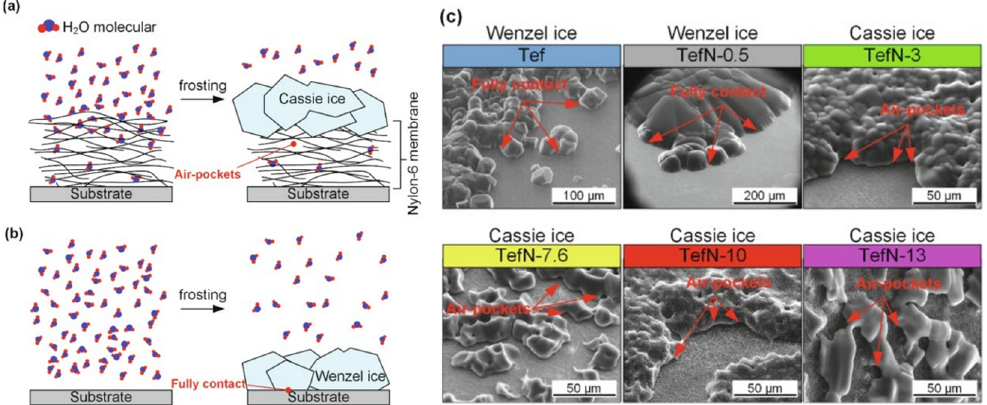
Figure 9. Ice morphology on studied surfaces. ( a ) Cassie ice yielded by a layer-by-layer stacked